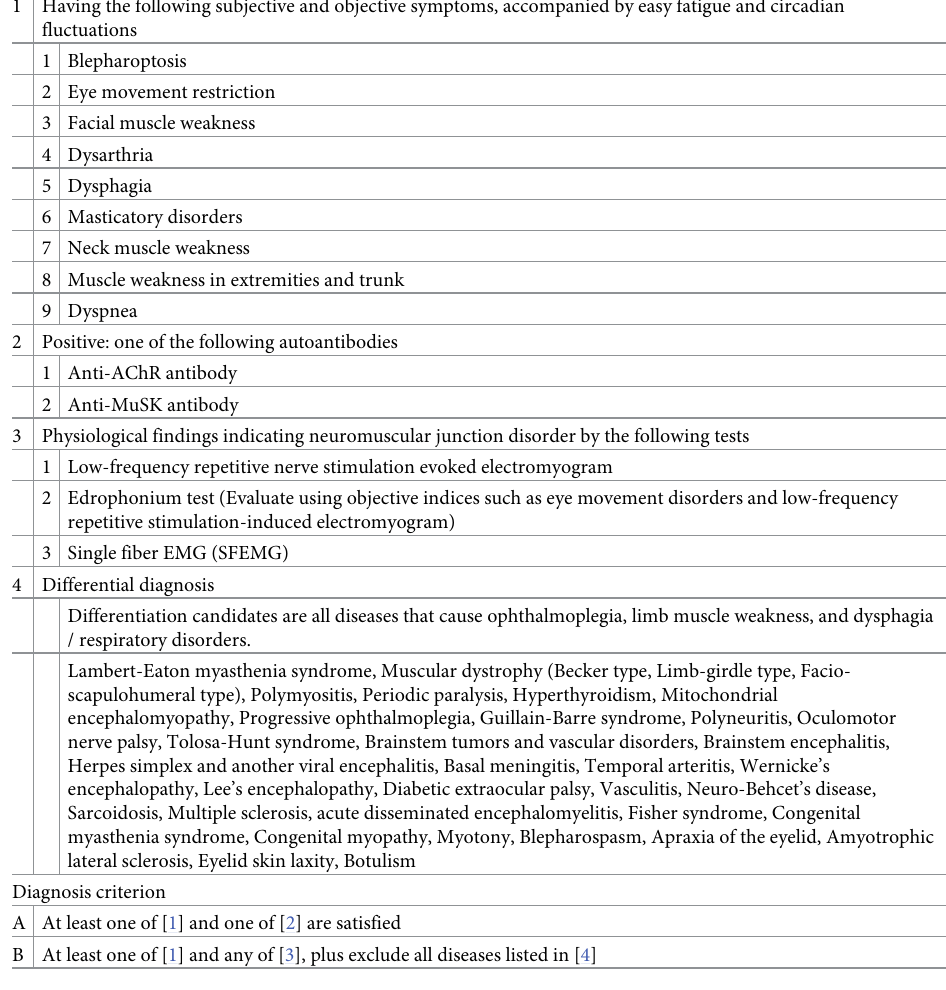
Table 1. Diagnostic criteria for